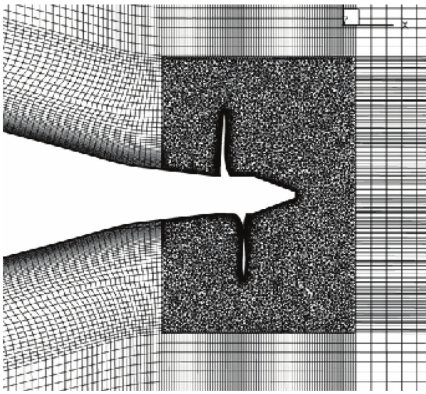
Figure 8: Computational grid with hull.